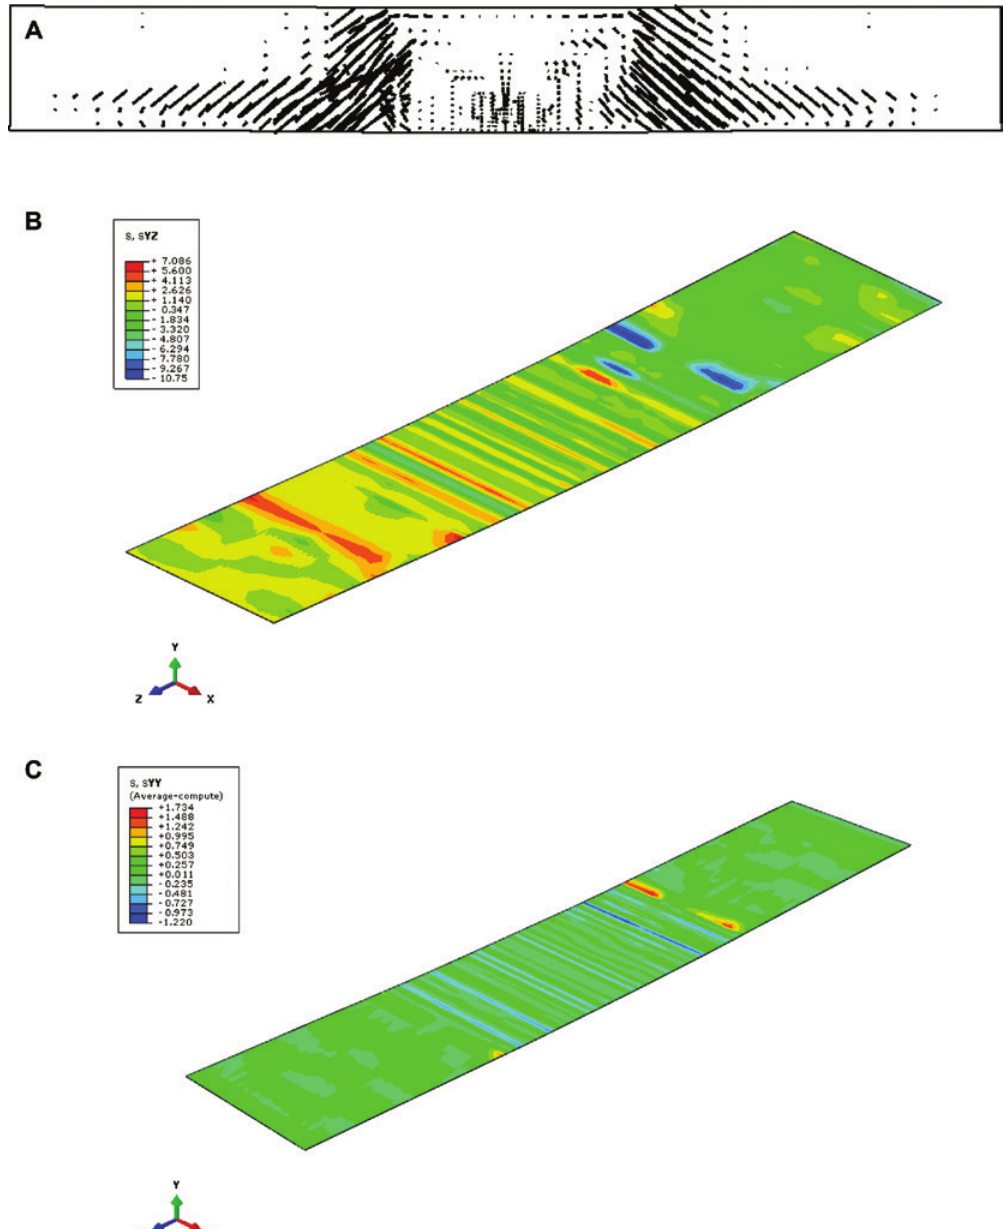
Figure 24: Distribution of (A) concrete cracking, (B) shear stresses in the adhesive layer, and (C) normal stresses in the adhesive layer of a CFRP-retrofitted RC beam after the last